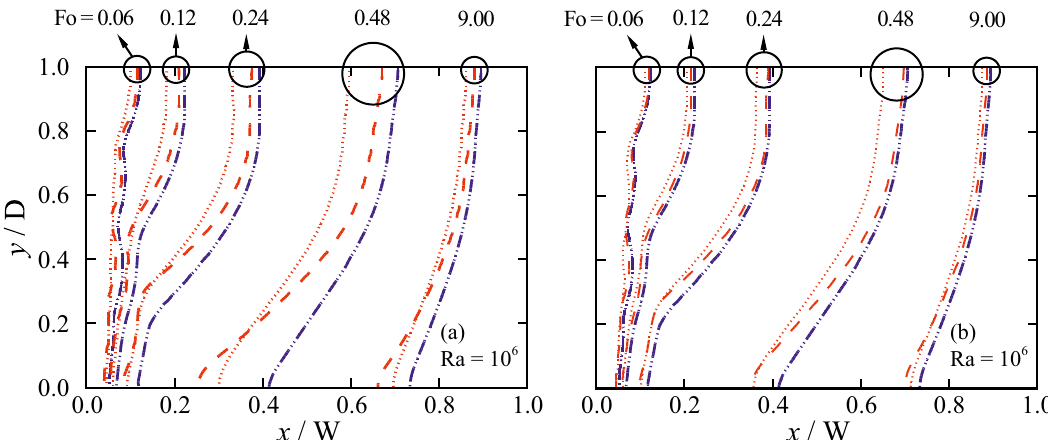
Figure 12. Time evolution of melting front positions ( f L = 1) for isothermal phase-change (blue lines, θ = 0) and non-isothermal phase-change (red lines: ( a ) ∆ T m = 50K, ∆ T w = 750K, θ = 1/15; and ( b ) ∆ T ∆ T m = 25K, w = 750K, θ = 1/30) problems. Dashed lines: C = 1 × 10 C = 1 × 10 8 kgs − 1 m − 3 (Ra = 10 6